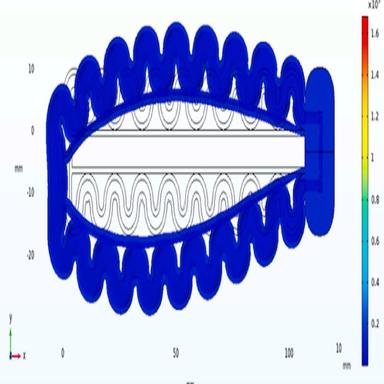
FEA - bending-open behavior under a pressure of 25 psi. Von Mises Stress .